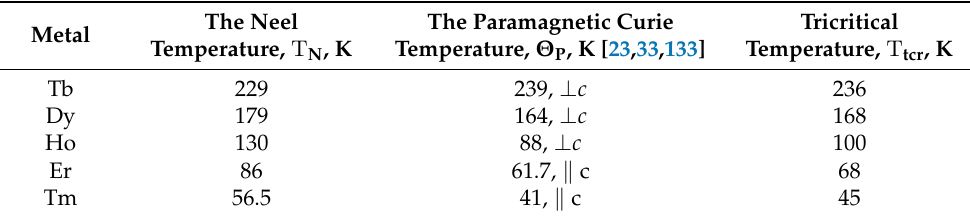
Table 1. Theoretical values of the tricritical temperatures of heavy